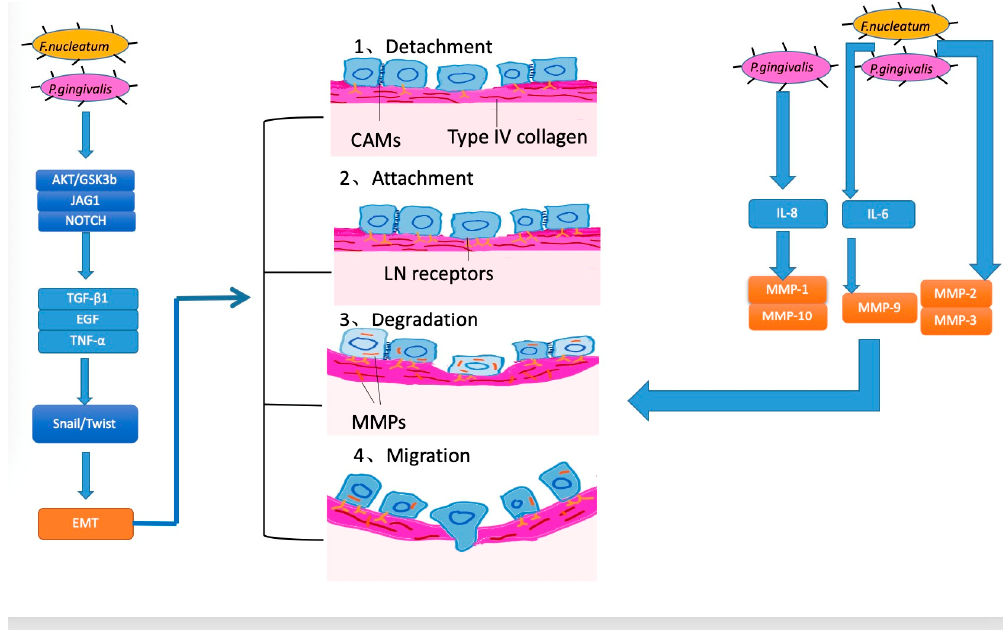
Figure 3. Mechanisms for how oral bacteria promote invasion and metastasis.